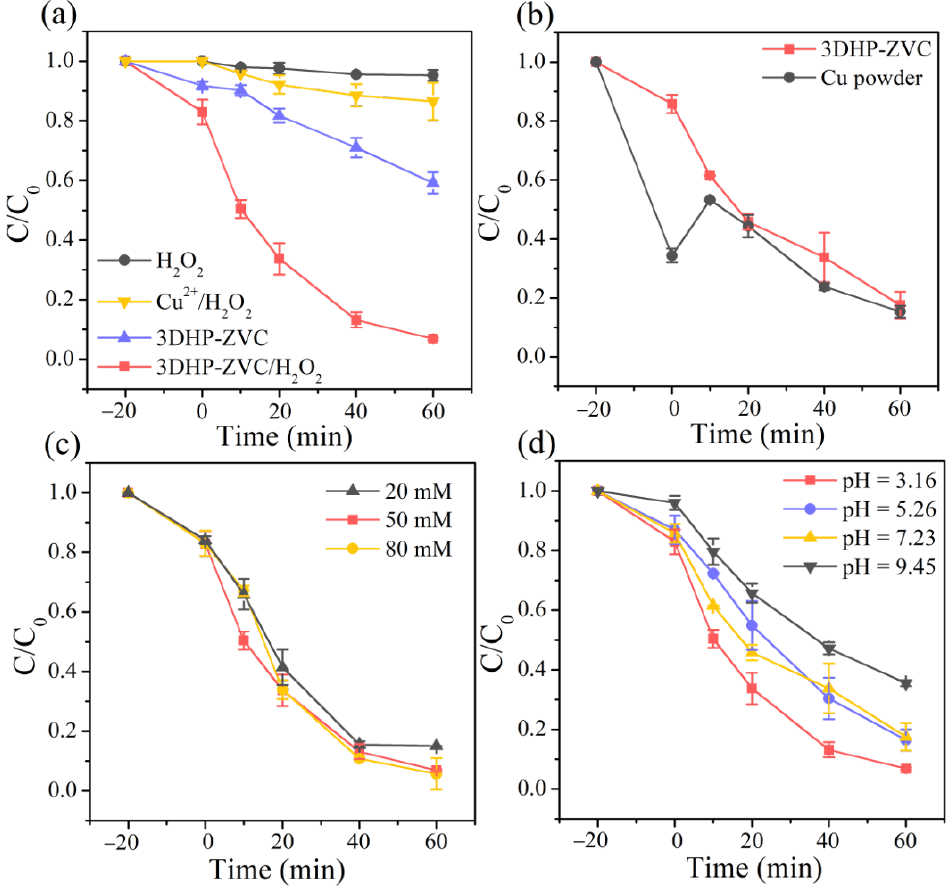
Figure 2. TC degradation ( a ) in different systems under optimal conditions, ( b ) by different catalyst- H 2 O 2 systems at pH = 7.23, effects of ( c ) H 2 O 2 dosage, and ( d ) initial pH value on the degradation of TC.